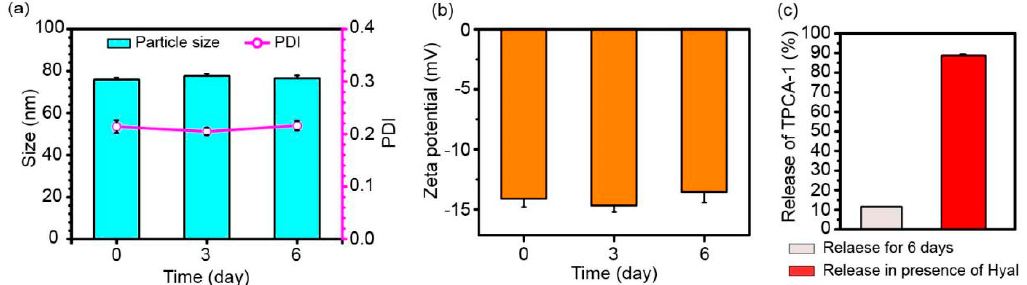
Figure 2. Stability and release of HA-AuNCs/T/P: ( a ) Particle size, PDI and ( b ) zeta potential of HA-AuNCs/T/P for 6 days at 4 ◦ C; ( c ) Release of TPCA-1 from HA-AuNCs/T/P during six days’ storage or in the presence of Hyal. Data are presented as mean ± SD ( n =